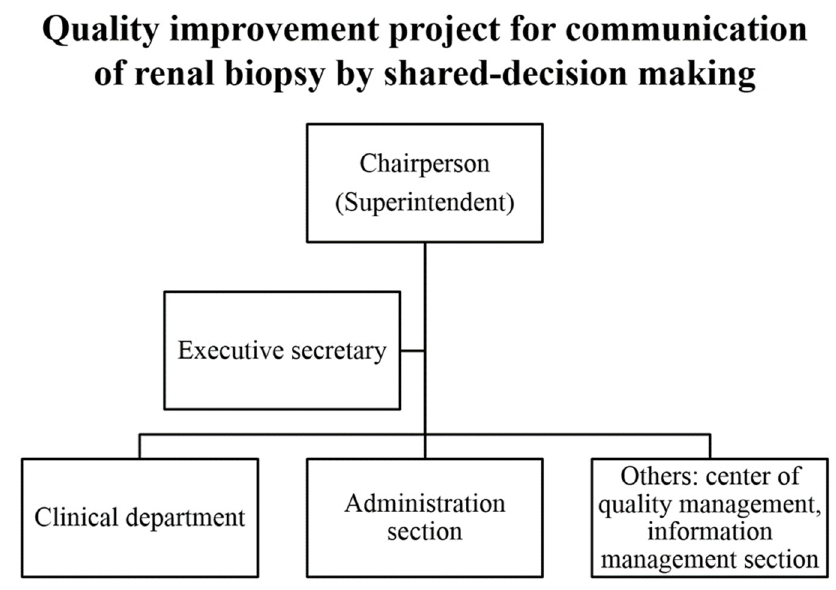
Figure 1. Core team of quality improvement projection for communication of renal biopsy by shared decision making.